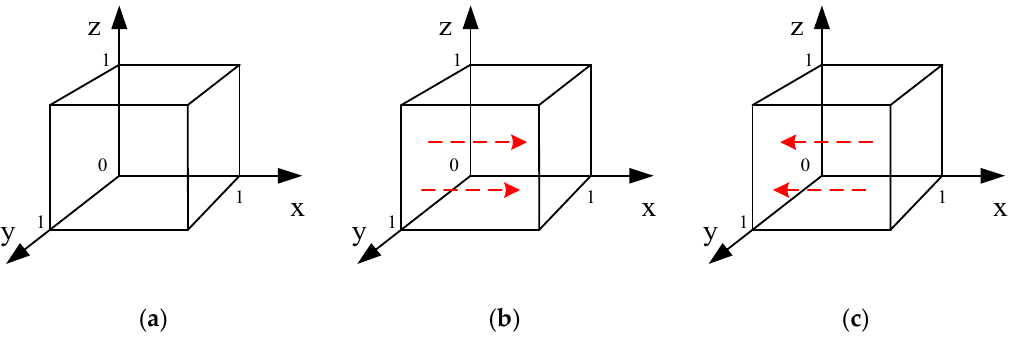
Figure 2. Dynamic evolution trend chart of government.